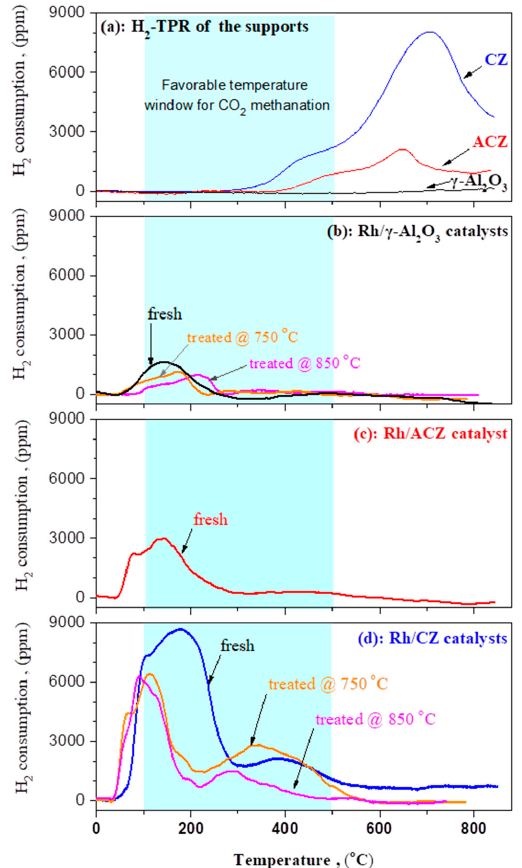
Figure 1. H 2 -TPR profiles of ( a ) the γ -Al 2 O 3 , ACZ, and CZ supports; ( b ) fresh, treated at 750 °C, and treated at 850 °C Rh/ γ -Al 2 O 3 catalysts; ( c ) fresh Rh/ACZ catalyst; ( d ) fresh, treated at 750 °C, and treated at 850 °C Rh/CZ catalysts.